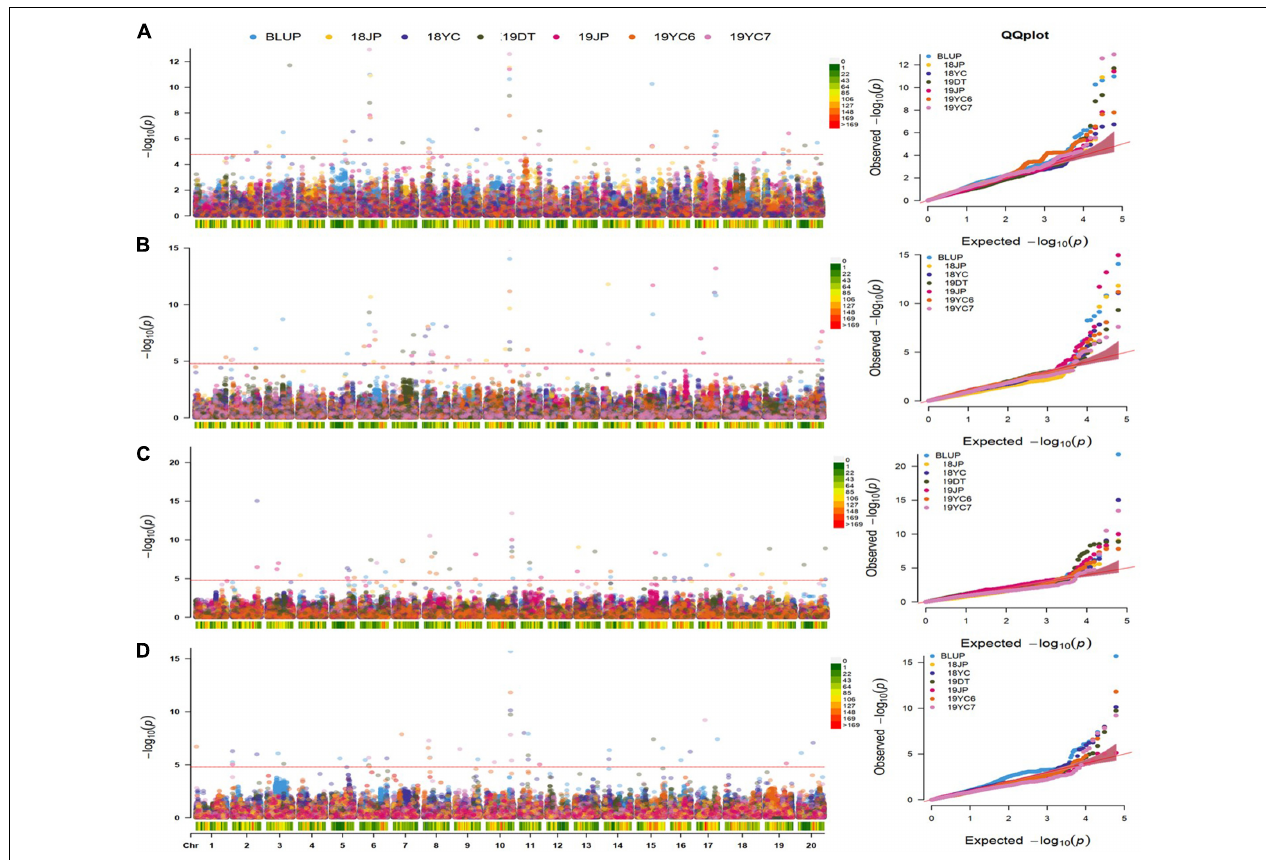
FIGURE 4 | Manhattan and quantile–quantile plots for four GSTs in five different environments and BLUPs. (A–D) represent the Manhattan plots and Q-Q plots for the days to flowering, pod beginning, seed formation and maturity initiation, respectively. 18 and 19 represent the years of 2018 and 2019, DT : Dangtu; JP : Jiangpu; 2019YC6 and 2019YC7 means the planting date of June and July in Yancheng city, respectively. Red Line represents the significance threshold as determined by Bonferroni multiple comparisons corrections equivalent to –log 10 ( p ) =